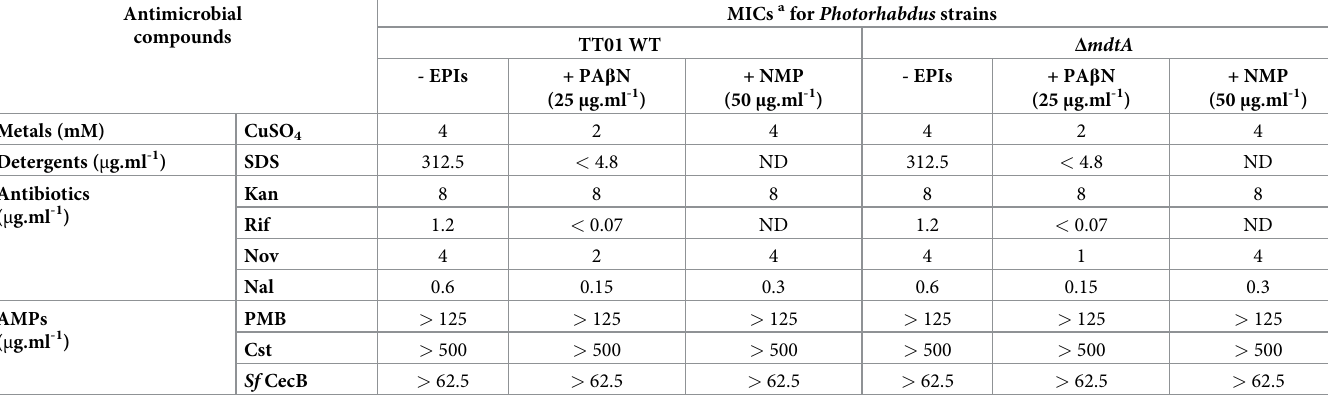
Table 3. Minimum growth-inhibitory concentrations (MICs) a of various antimicrobial and toxic compounds in the presence and absence of RND-type efflux pump inhibitors (PA β N or NMP) for wild-type P . luminescens TT01 (TT01 WT), the Δ mdtA mutant and its derivatives harbouring pBBR1-MCS5 or pBB -mdtABC . Antimicrobial